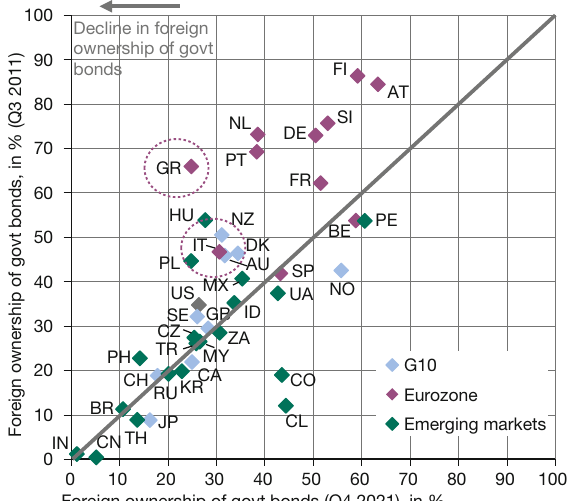
advanced economies in %